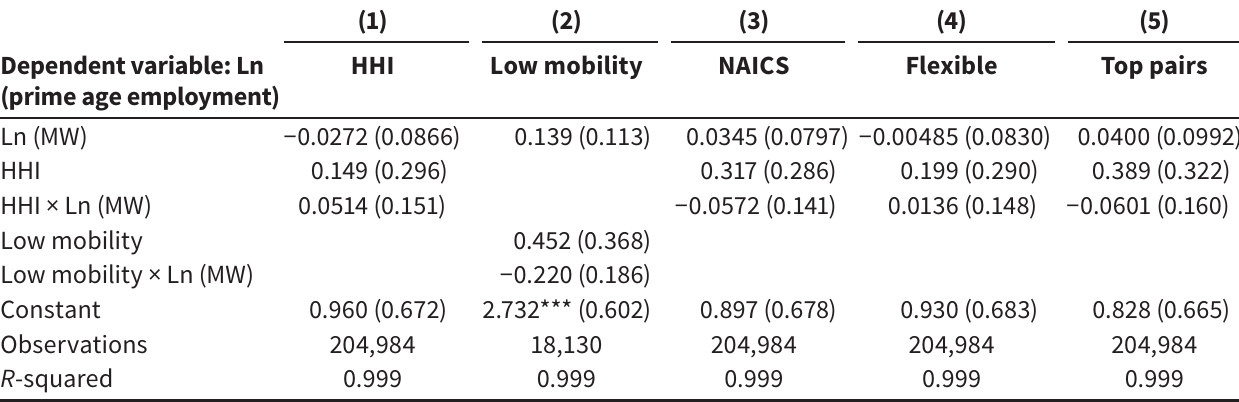
Effects of the log of the MW interacted with the HHI and low mobility on the log of prime